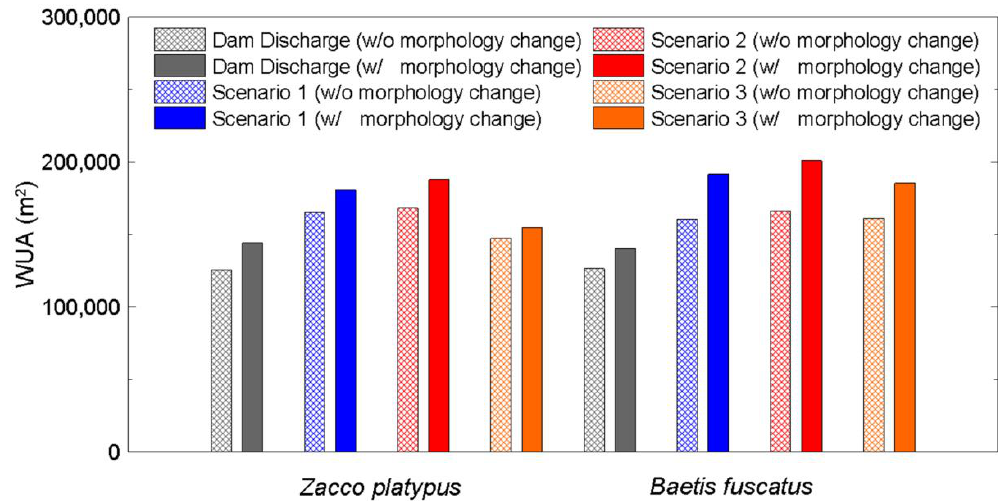
Figure 12. The change of WUA for the target species (with and without morphology change).